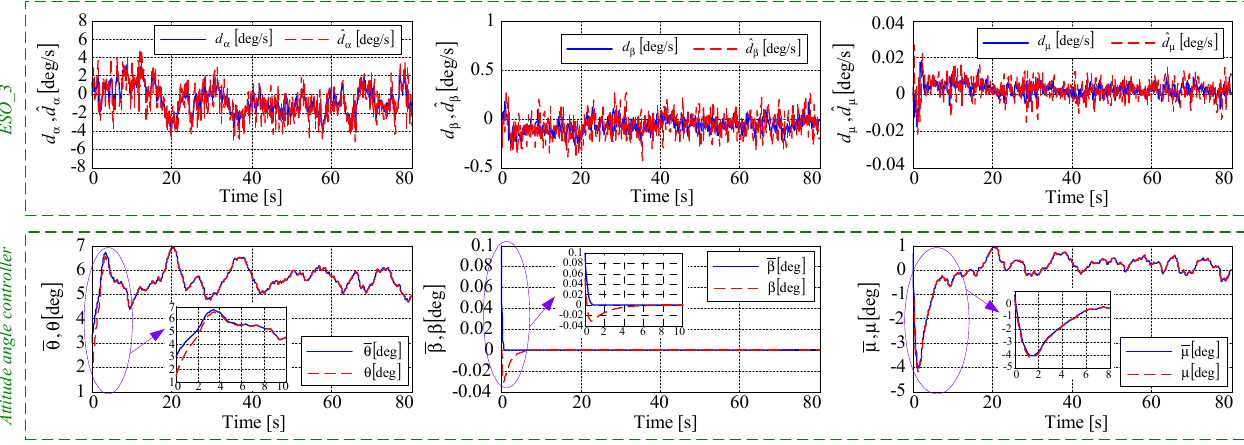
Figure 10. Time histories of the variables associated to ESO_3 and attitude angle control.